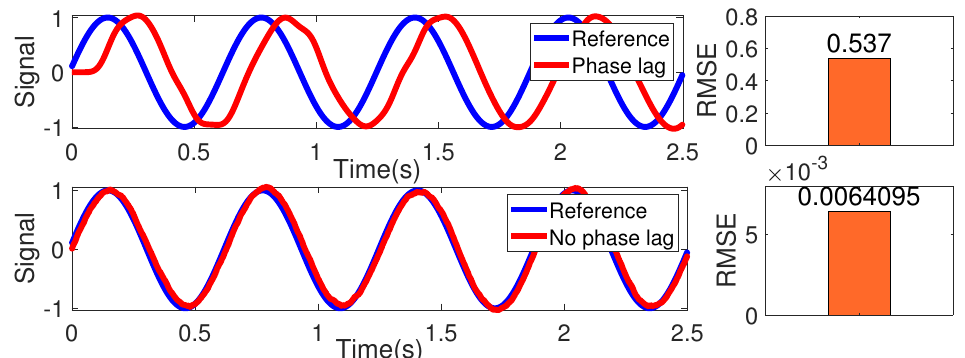
Figure 7. Simulation results of signal process based on phase-lag-free LPF. The first subfigure is the original signal with phase lag, the second subfigure is the signal processed by phase-lag-free